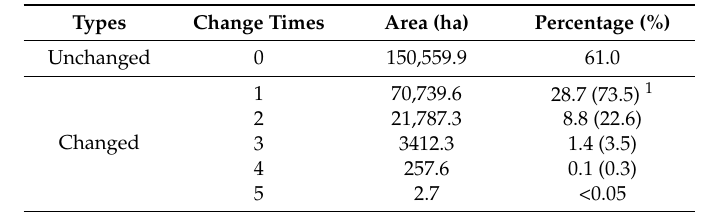
Figure 6. Area of wetland-related land cover change (note: CW, coastal wetland, including sea, mud flat, Scirpus , Spartina ; SW, swamp wetland, including herb; AW, artificial wetland, including water and paddy field; Cons., construction land; Dryl., dryland).